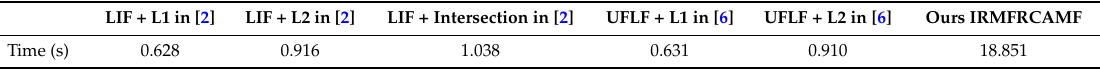
Table 15. Affinity matrix construction times of different methods from